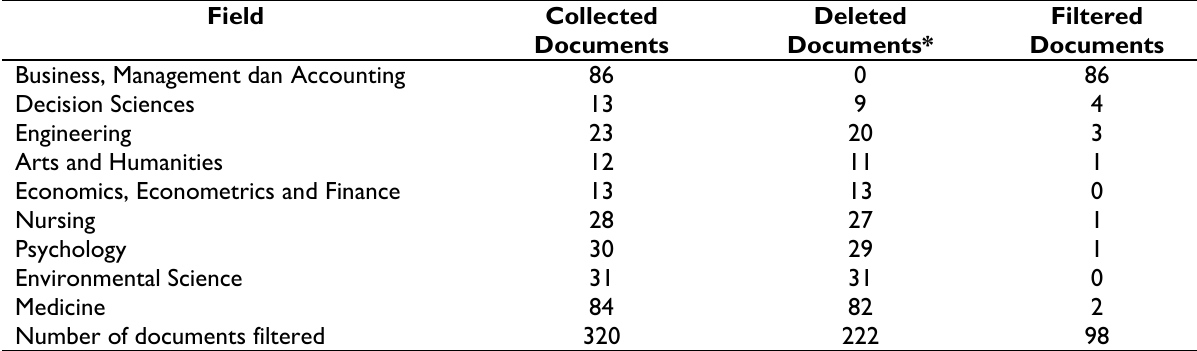
Table 1. Article Selection from SCOPUS